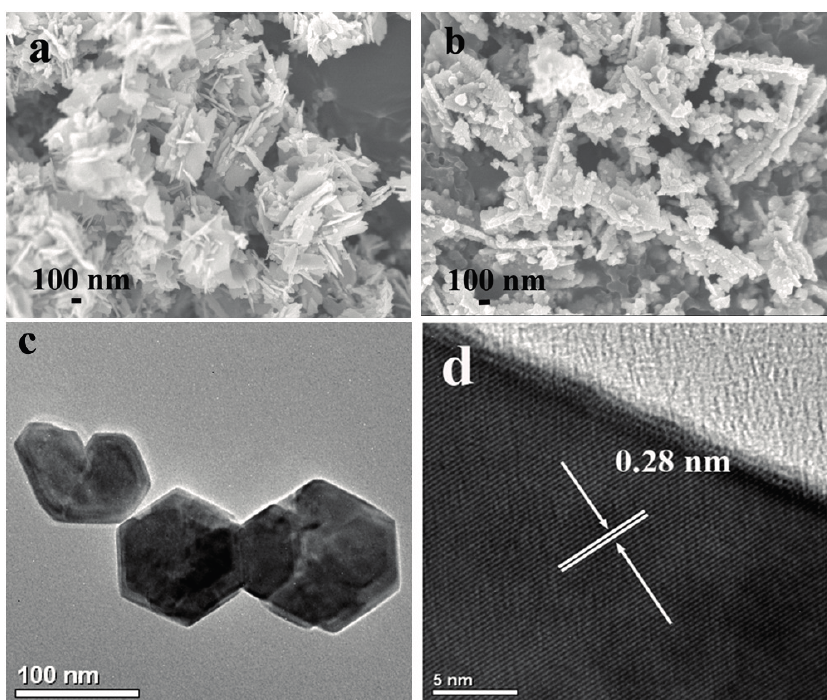
Figure 2. ( a ) SEM images of MEA–ZnO; ( b ) SEM image of clean ZnO; ( c ) TEM image of